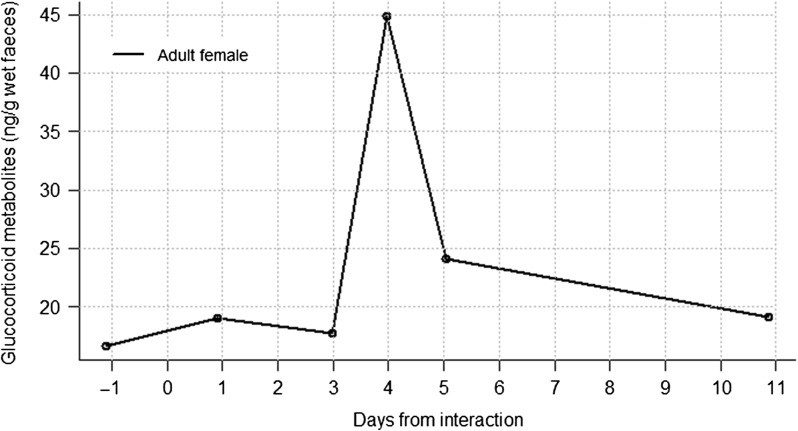
Faecal glucocorticoid metabolite concentration profile of an adult female in Kuryama group before and after an interaction with Inshuti group.